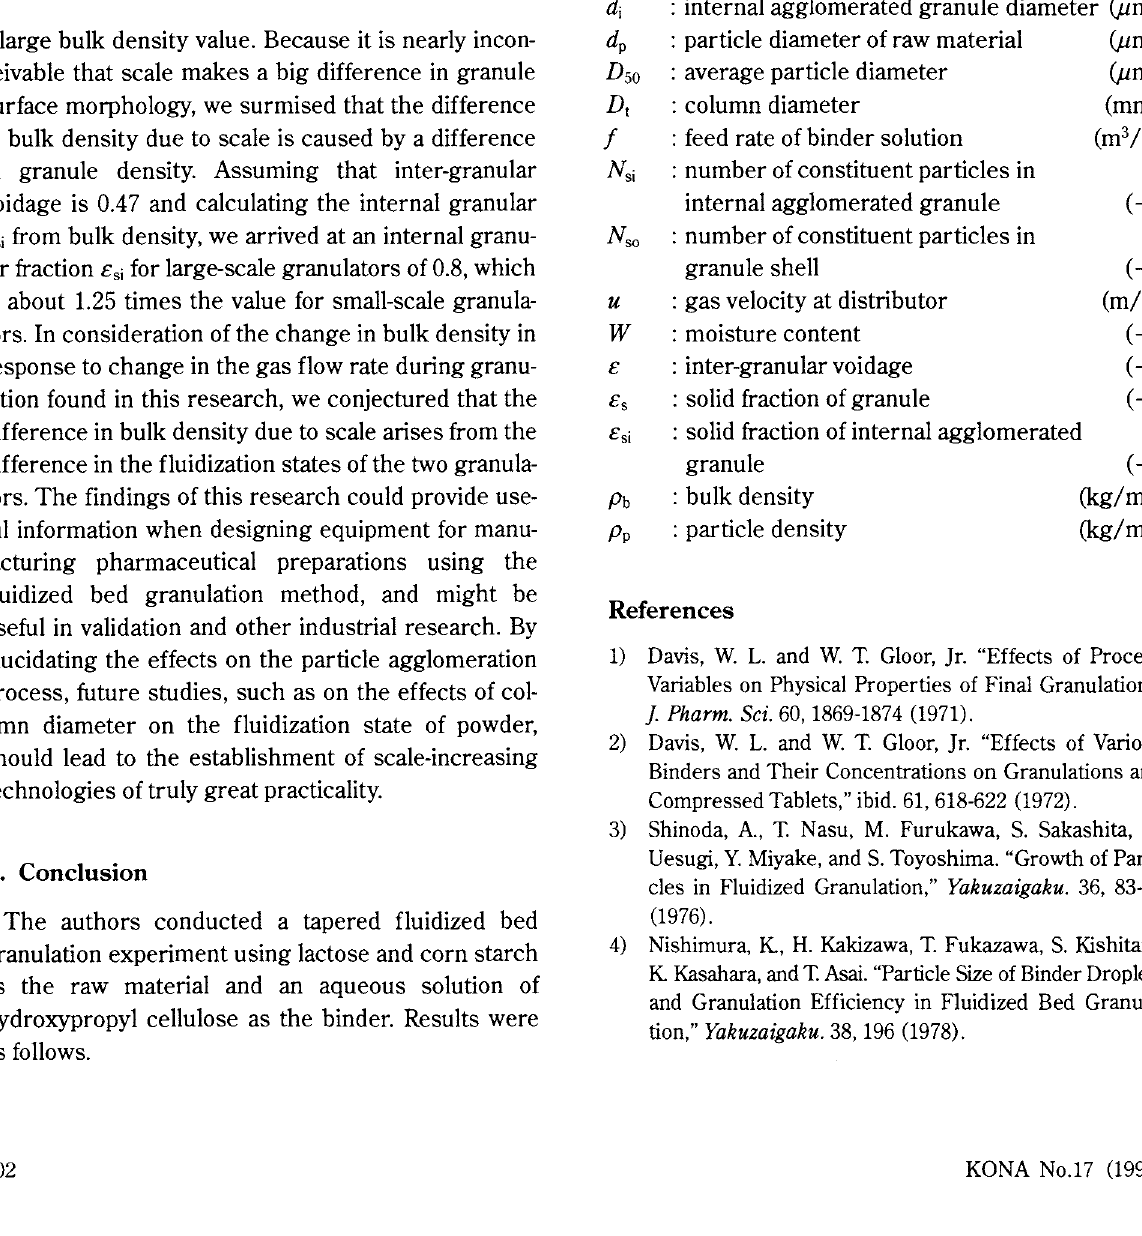
Effects of experimental apparatus scale on physical prop erties of